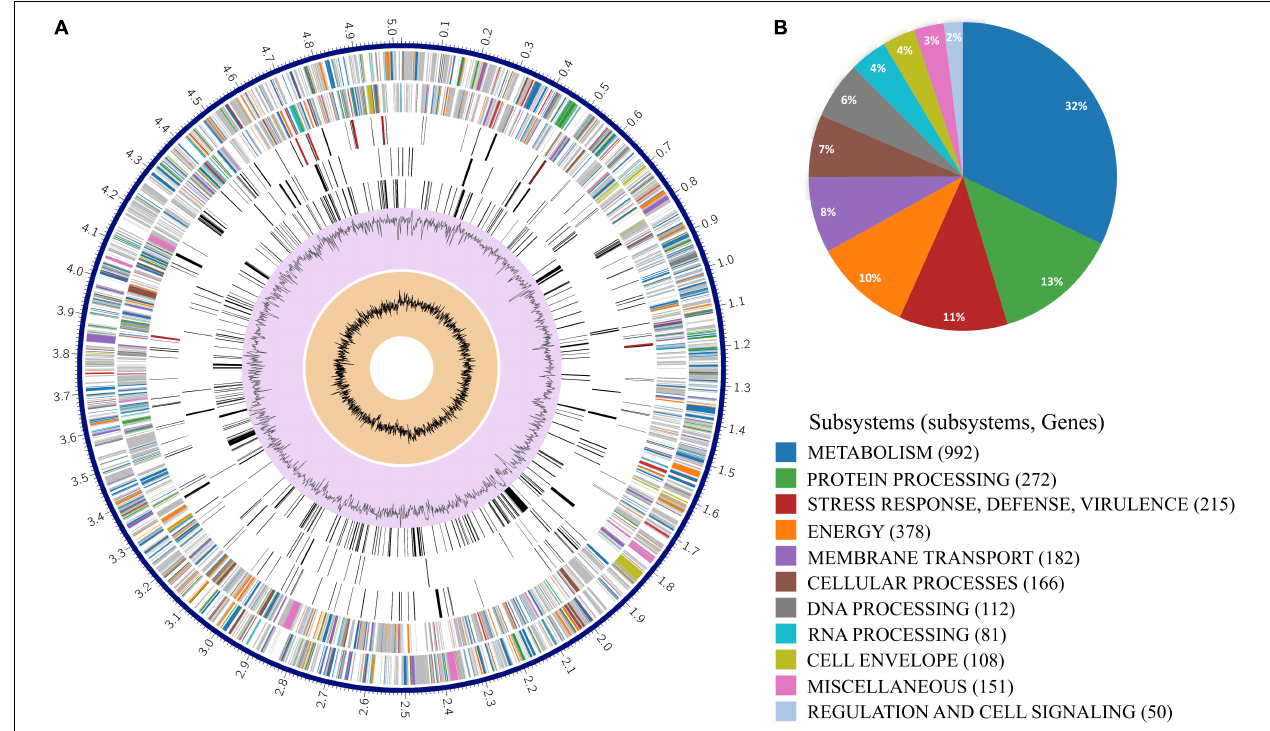
FIGURE 2 | Circular representation of strain SZESBLEC201 chromosome. (A) From the outer to inner rings: the assembled contig, forward strand CDSs, reverse strand CDSs, RNA genes, CDSs with homology to known transporters, CDSs with homology to known virulence factors, genome GC content, and distribution of the GC skew. Colors of the CDSs on the forward and reverse strand indicate the subsystems that these genes belong to. (B) Proportions of each subsystem in the strain SZESBLEC201